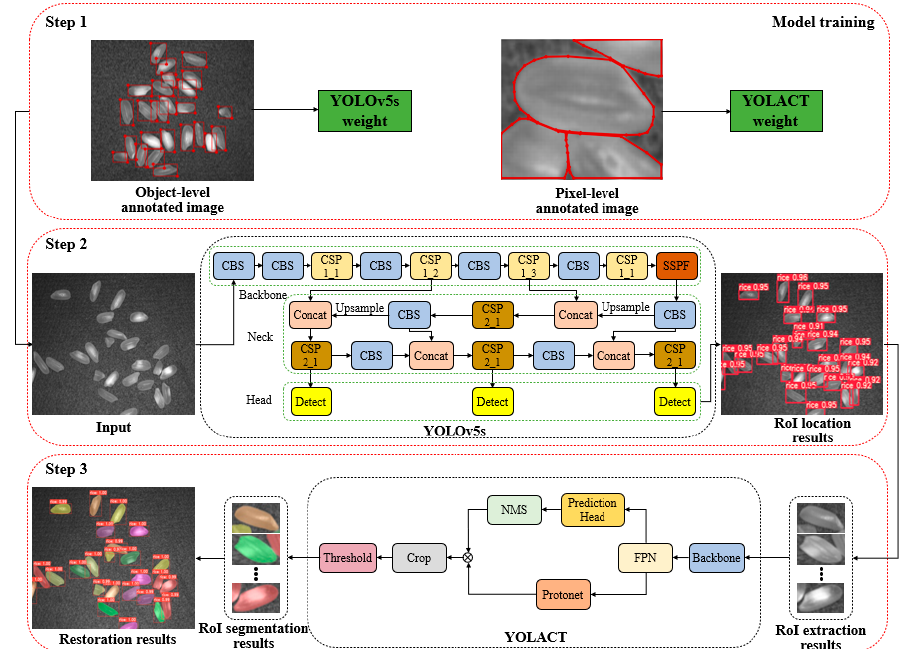
Figure 2. Flowchart of polished rice image segmentation.